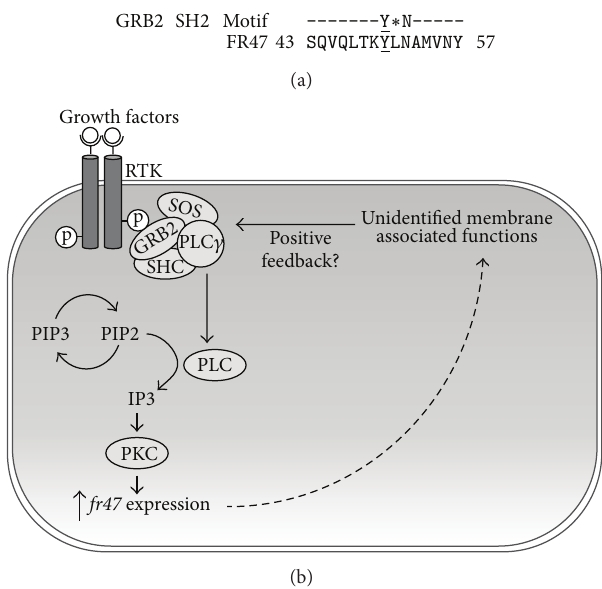
Figure 2: Prediction of SH2 binding motif present in FR47. To elu- cidate a possible membrane associated function for FR47, DOMPEP was used to identify any possible conserved SH2 binding motifs. (a) Positive identification of the GRB2 SH2 domain phosphotyrosine bindingsitewithintheFR47primaryaminoacidsequence;“ ∗ ”indi- cates hydrophobic amino acids. (b) Hypothesized effect of GRB2- SOS signaling on IP3 production and PKC activation. Increased PKC activity is known to increase fr47 production and the presence of a GRB2 binding motif in FR47 could suggest that FR47 may create a feedback mechanism to regulate FR47